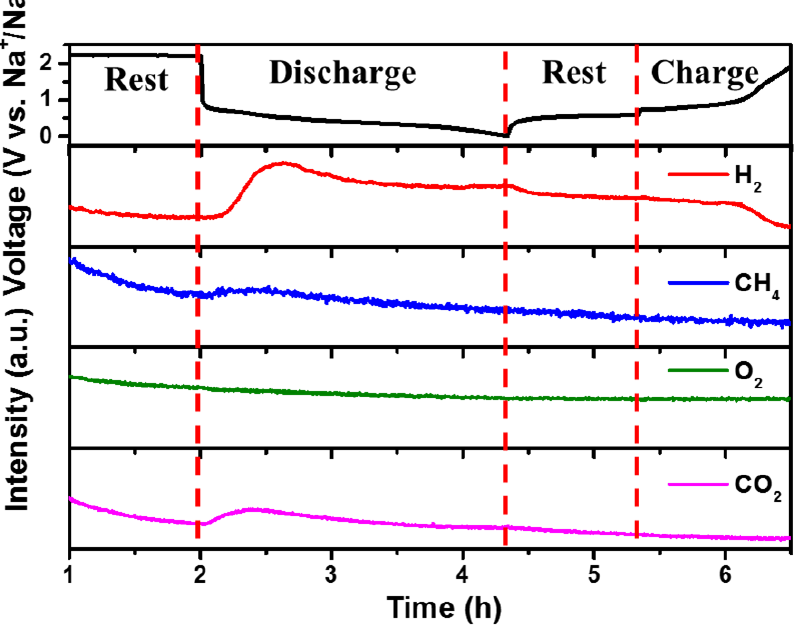
Figure 7. The on-line DEMS results collected by a Swagelok cell with Bi 1 Sb 1 @C electrode and PC, 5 wt.% FEC, 1 M NaClO 4 electrolyte during rest and initial discharge–charge processes.